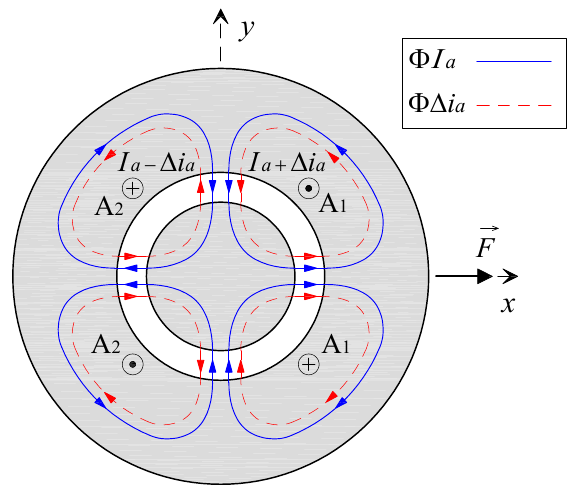
Figure 1. Magnetic flux produced by coils A 1 and A 2 . Where Φ I a and Φ∆ i a are the magnetic fluxes generated by currents I a and ∆ i a ,